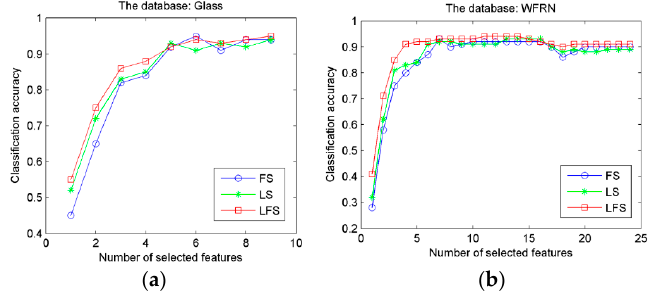
Figure 2. The classification results of different feature selection methods using the UCI database: ( a ) Glass; ( b ) WFRN.